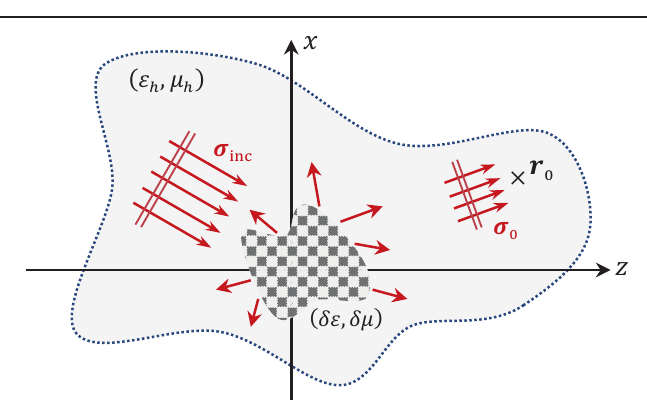
propagates along (cid:3167)(cid:3172)(cid:3161) ( (cid:2033) ) = (cid:3283) ( (cid:2033) ) + (cid:2012)(cid:2013) ( (cid:2200) , (cid:2033) ) and relative (cid:3283)